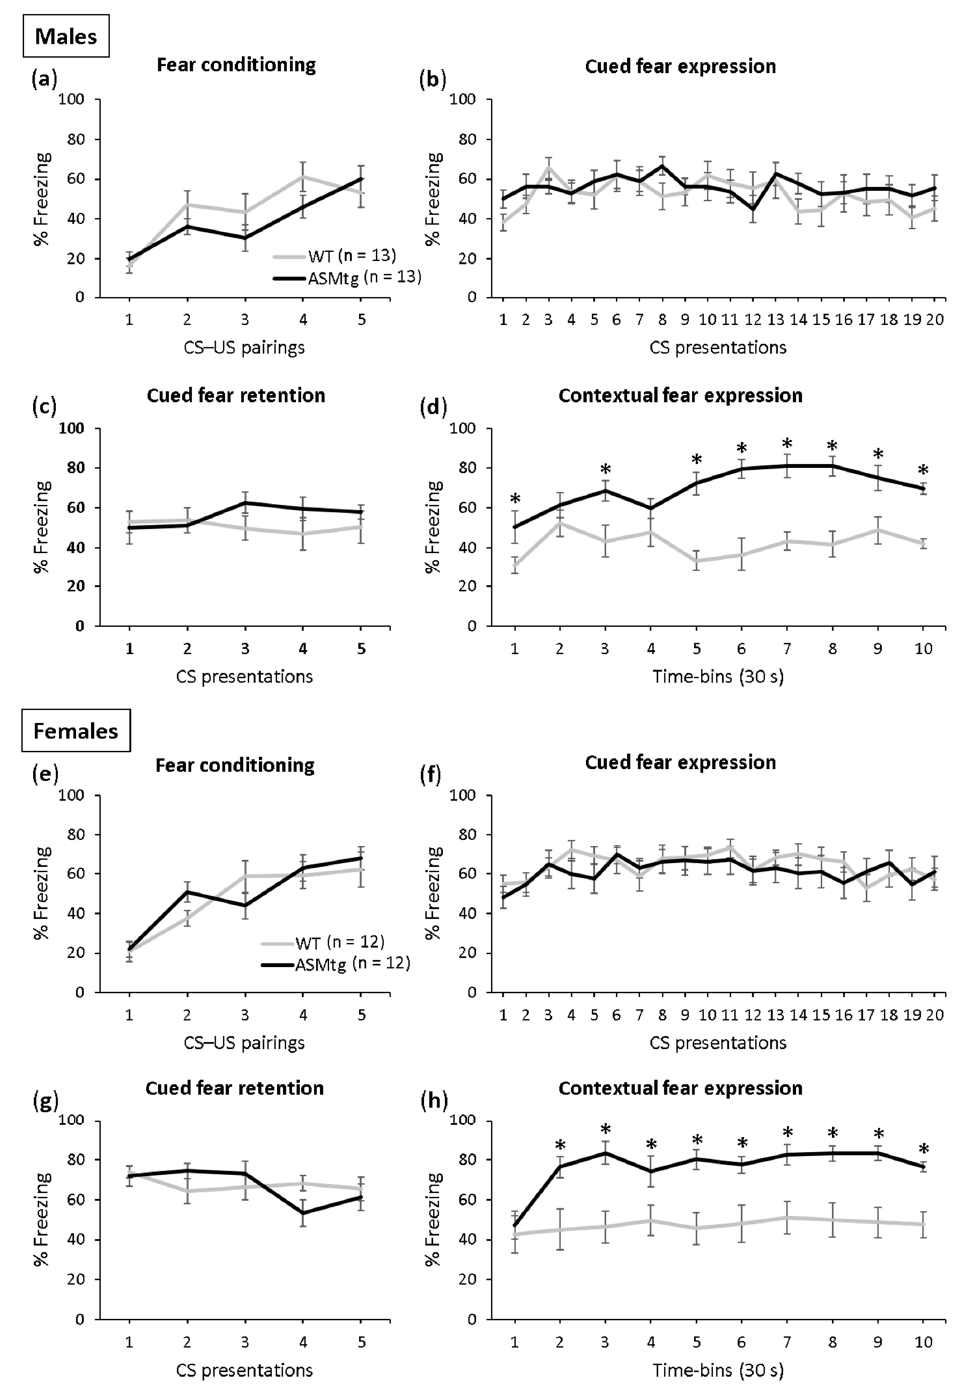
Figure 2. Acid sphingomyelinase (ASM) overexpression increases the expression of contextual fear in both male and female mice. ( a , e ) On day 1, the ASM transgenic (ASMtg) mice and wild-type littermates (WT) were fear conditioned in context A; ( b , f ) on day 2, the expression of cued fear (i.e., tone-elicited freezing) was assessed in context B; ( c , g ) on day 3, the retention of cued fear was assessed in context B; ( d , h ) on day 4, the expression of contextual fear was assessed in context A. Data represent the mean time of CS-elicited freezing ± SEM, and numbers in parentheses indicate group sizes. * p < 0.05 compared with WT mice.